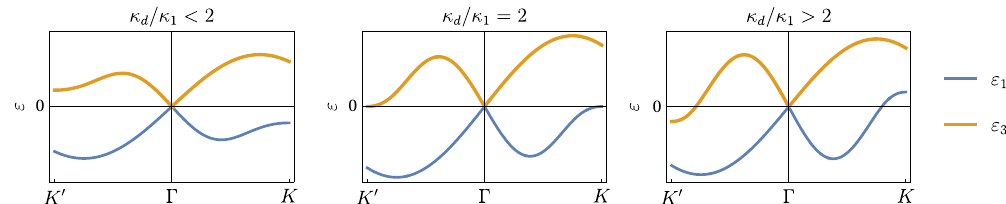
Figure 6: Spinon dispersion for the lower and upper bands, (cid:34) the Γ -K direction, for different values of the ratio κ are gapped at the K and K (cid:48) points. At the critical value κ the Fermi level at the K and K (cid:48) points, forming Fermi pockets for κ